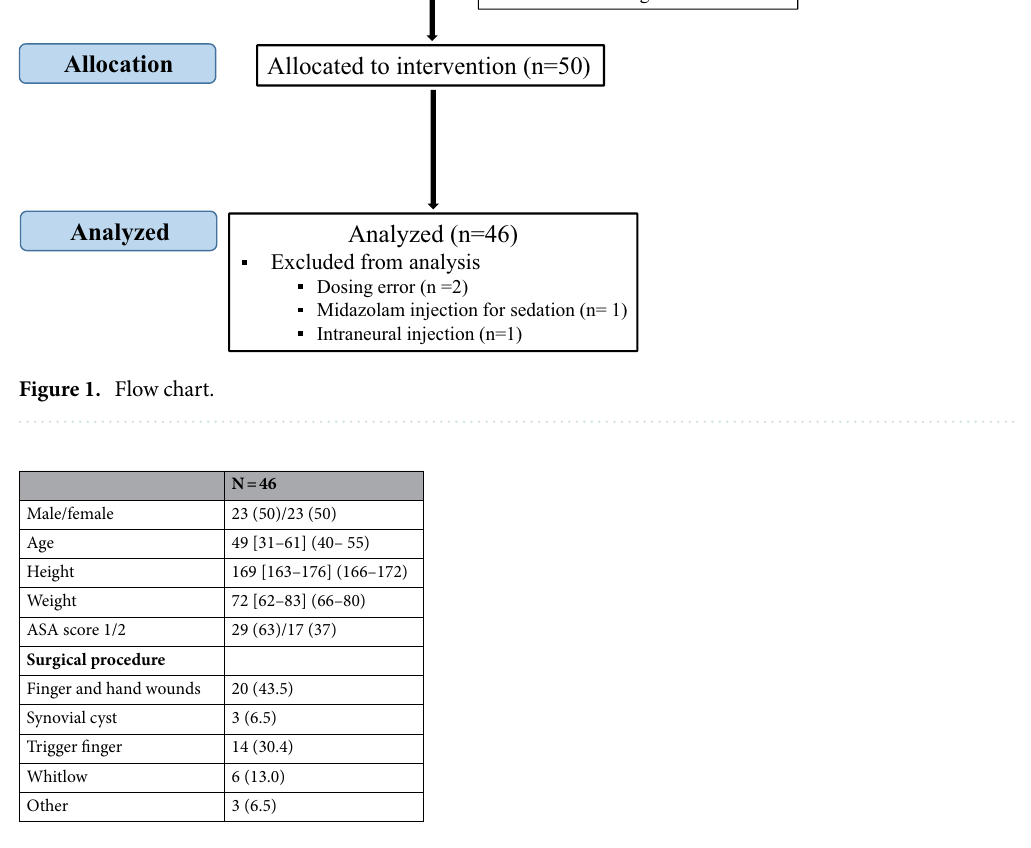
Table 1. Demographic data and surgical procedures. The results are presented as numbers (percentages) and medians [25th–75th percentiles] (95% confidence intervals).